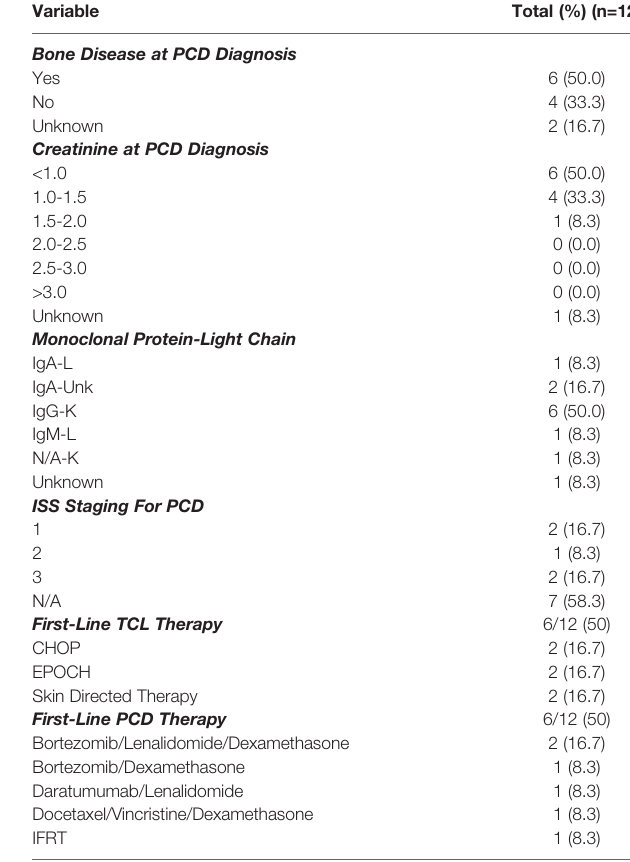
TABLE 3 | Baseline characteristics for patients with T-cell lymphoma